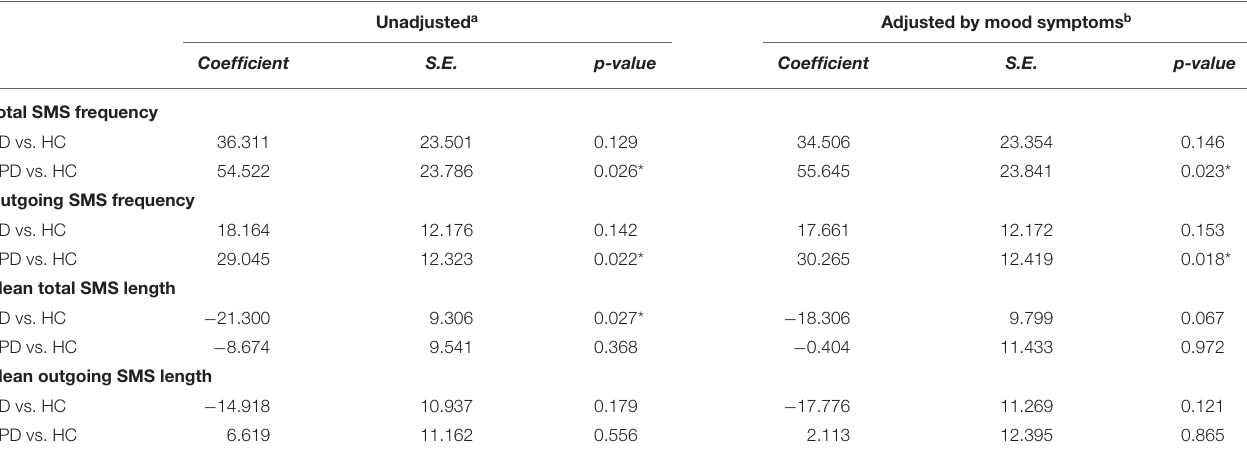
TABLE 5 | SMS data by diagnosis (adjusted by mood